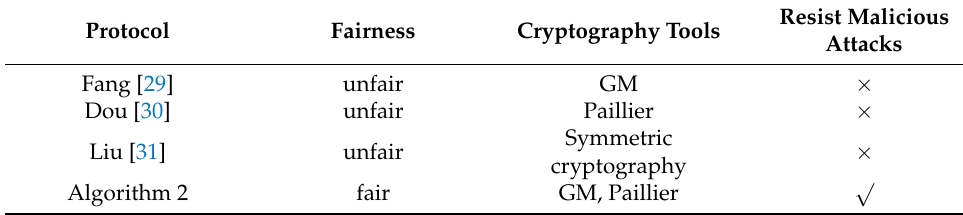
Table 1. Protocol’s performance